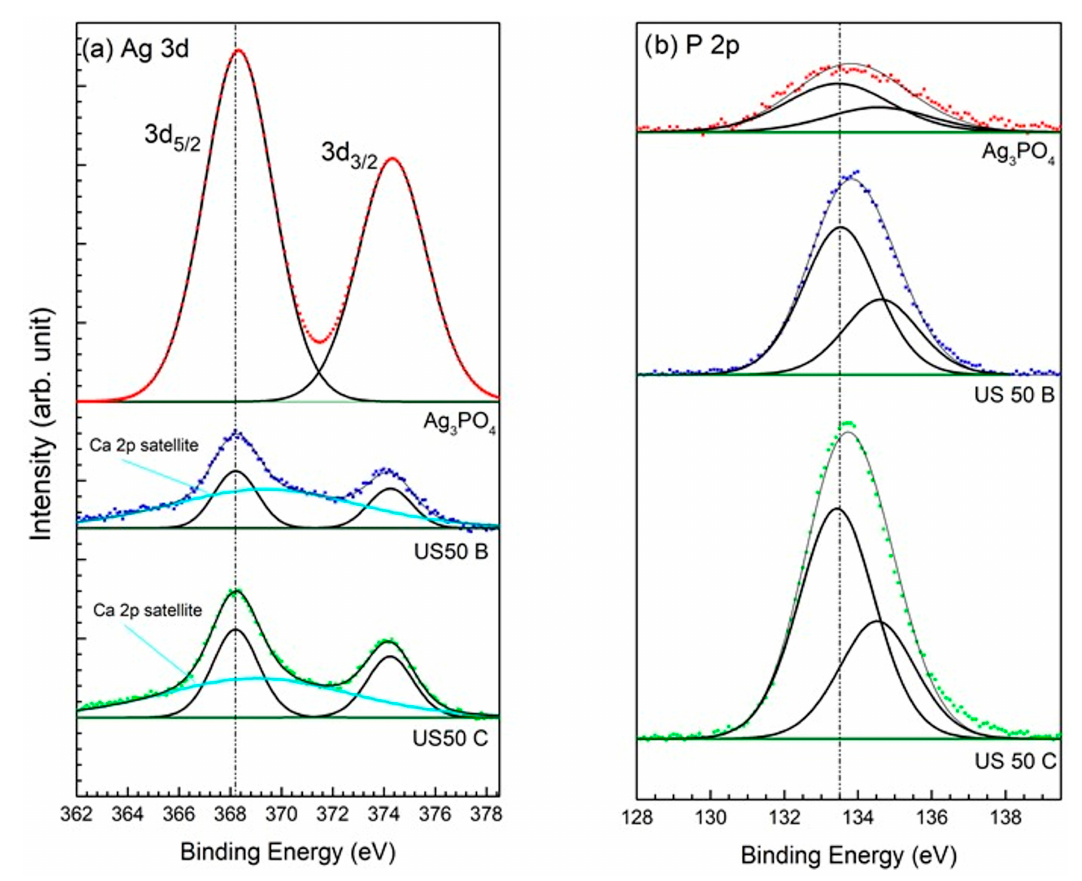
Figure 6. XPS spectra of the Ag 3d ( a ) and P 2p ( b ) regions of US50C, US50B, and the Ag 3 PO 4 sample reference. The BE position of the main peaks is indicated by a dotted line. Table 3. The values of BE and KE for the Ag 3d 5/2 and Ag M 4 N 5 N 5 peaks, the Auger parameter α ’, and the Ag oxidation state in the OMP@silver